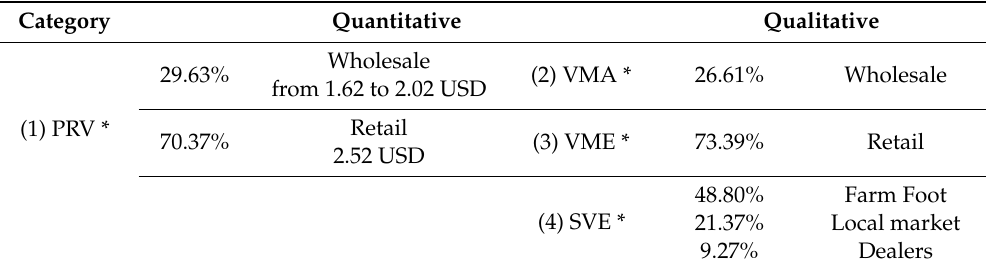
Table 5. Main results of the Mexican UPAs. Marketing